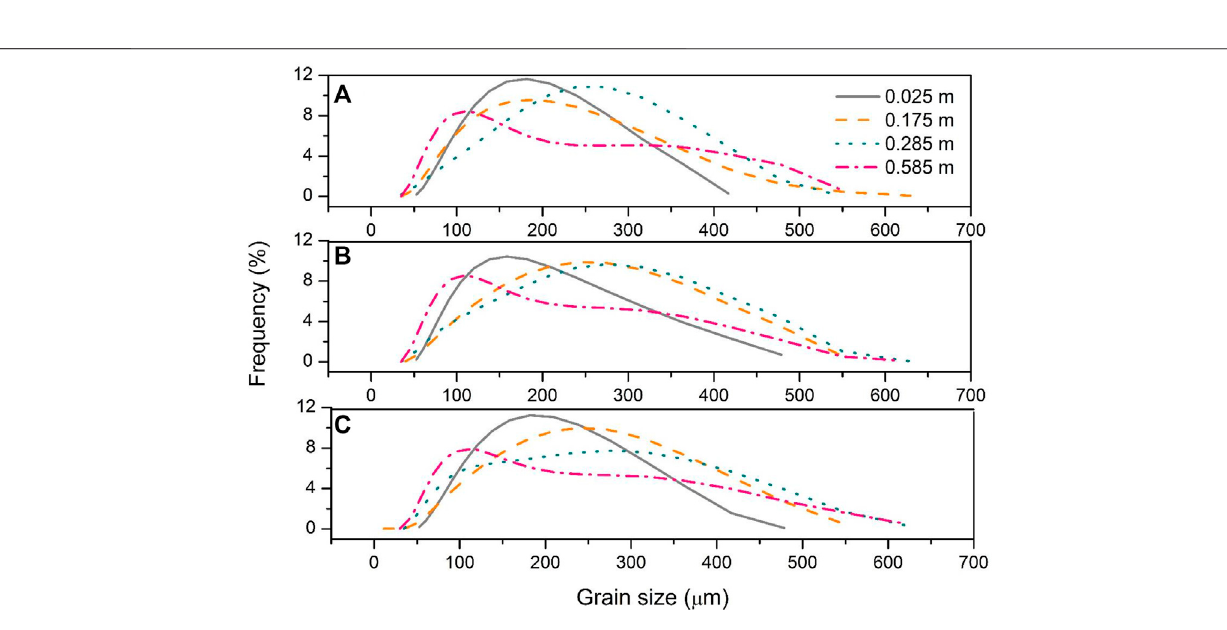
Frontiers in Environmental Science |